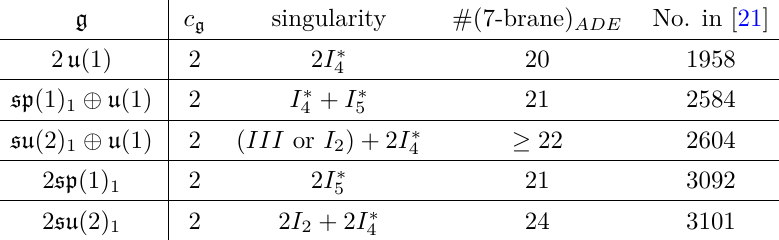
2 . Note that sp (1) comes from I ∗ singularity, and g ≤ 5